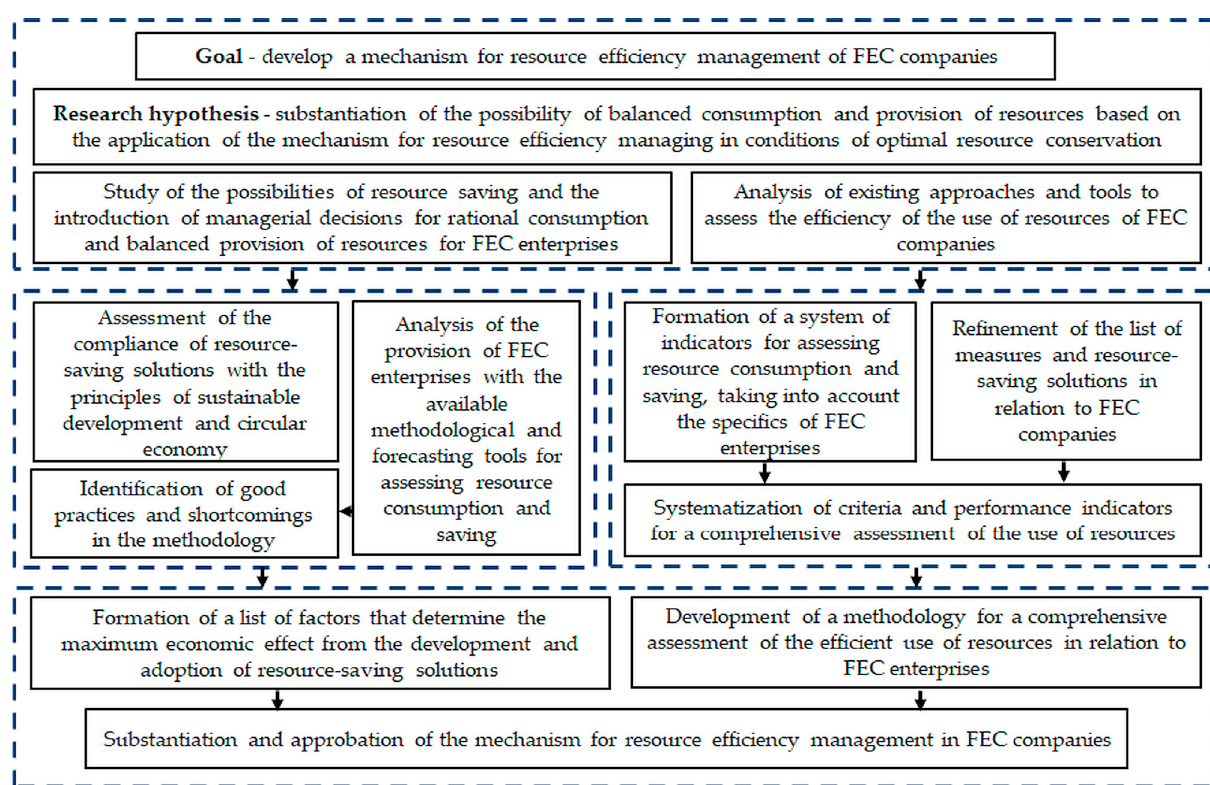
Figure 1. Research logic. Abbreviations used: FEC—fuel and energy complex.